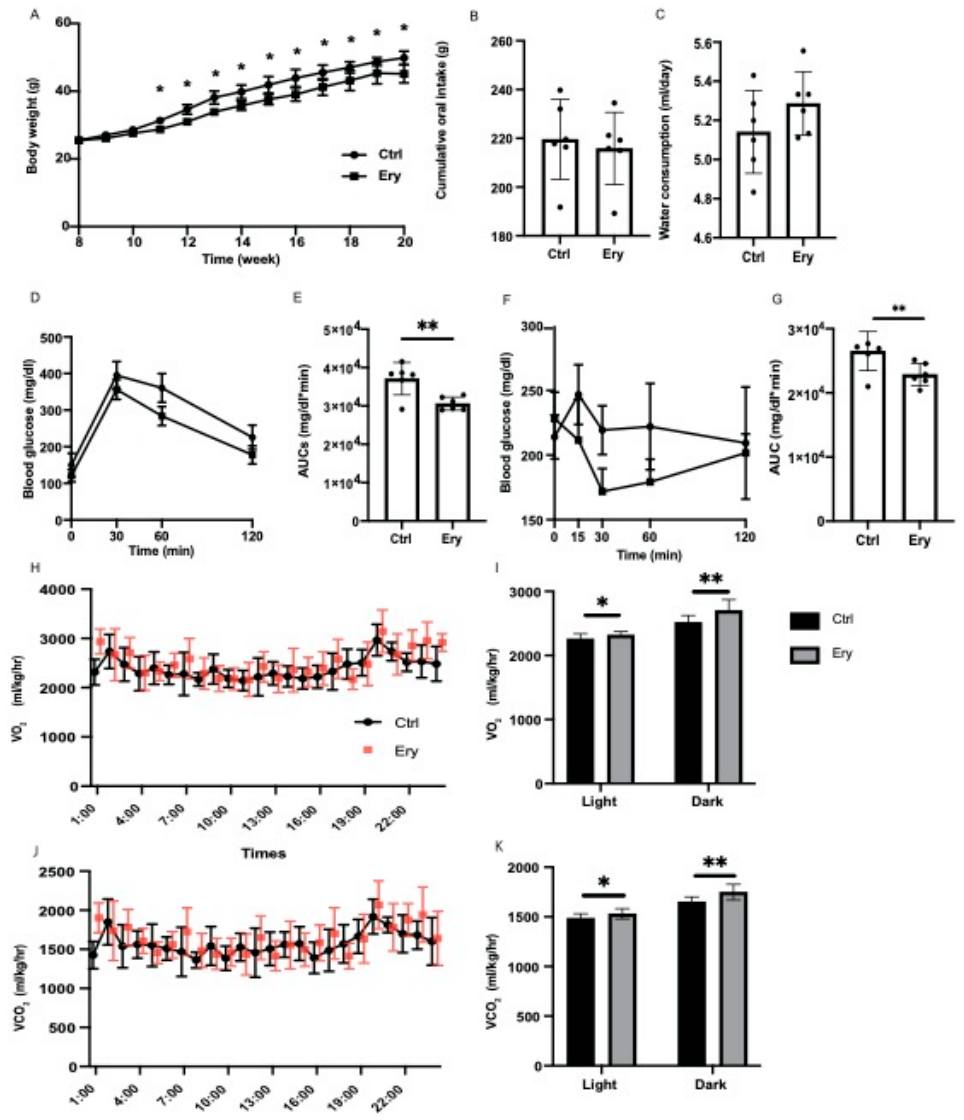
Figure 1. Erythritol administration significantly ameliorated impaired glucose tolerance, obesity, and metabolic disorders. ( A ) Changes in the body weights of the mice ( n = 6). *, weight of Ery group